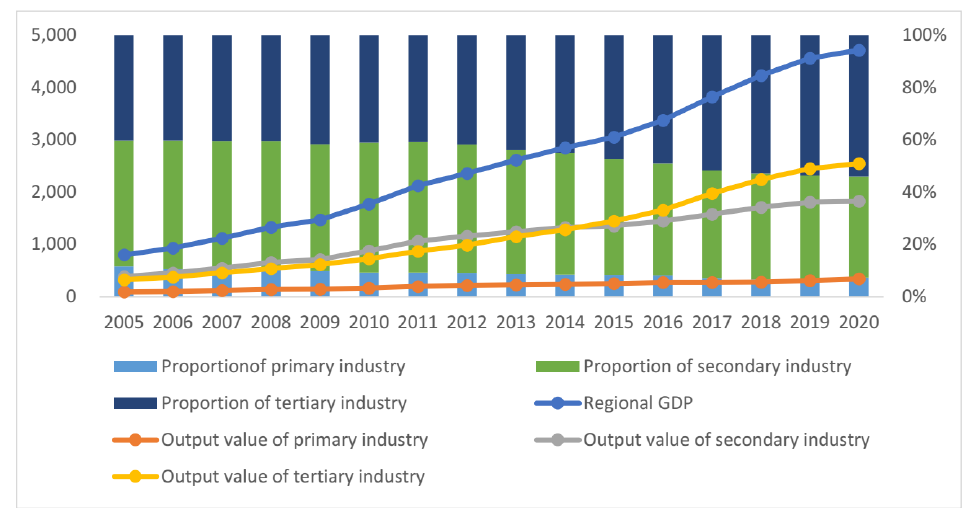
Figure 2. Three industries’ output value (CNY billion) and structure (%) of YREB (data source: Statistical Yearbooks of provinces and